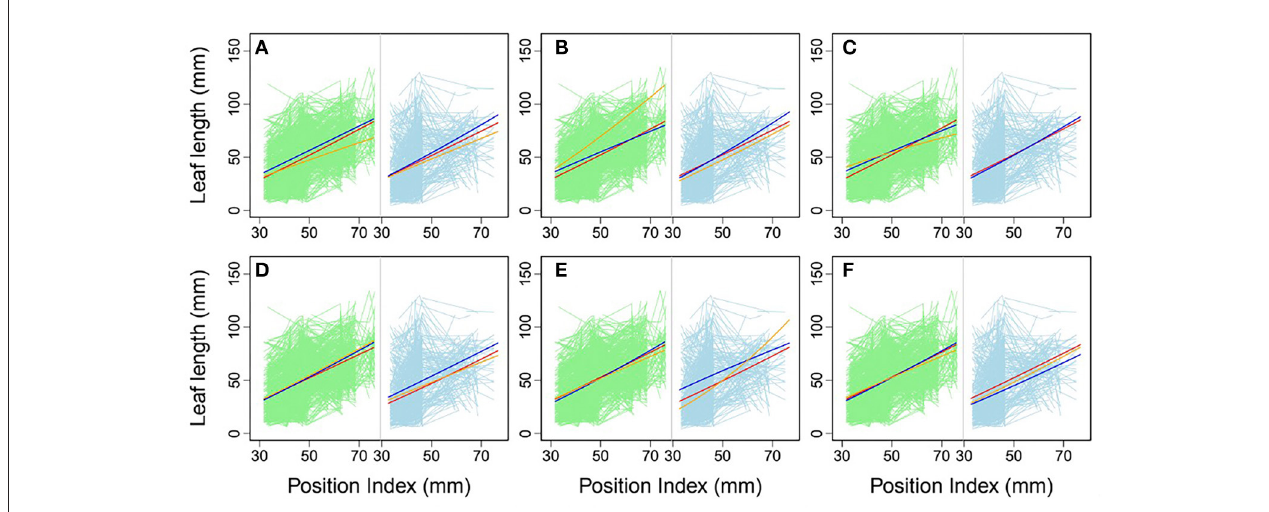
FIGURE 7 | Comparison of allelic heterophylly curves with significant single-nucleotide polymorphisms (SNPs) between the (A–C) control and (D–F) salt stress groups. Green and light blue lines indicate individual heterophylly curves vs. position index for the control and salt stress groups, respectively. Thick dark blue, red, and orange lines indicate three different heterophylly genotypes.